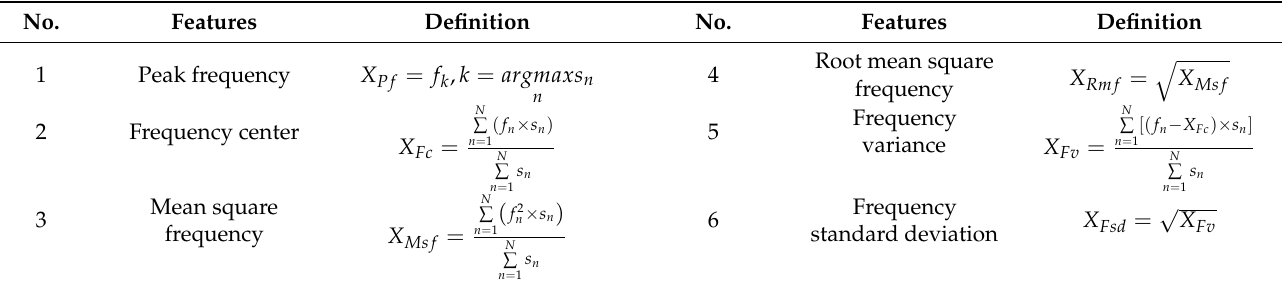
Figure 2. Time waveforms and frequency spectra of signals for an actual leaking plastic pipe and the same pipe after repair: ( a ) Signal waveform; ( b ) Frequency spectra. Table 1. The selected frequency-domain features.